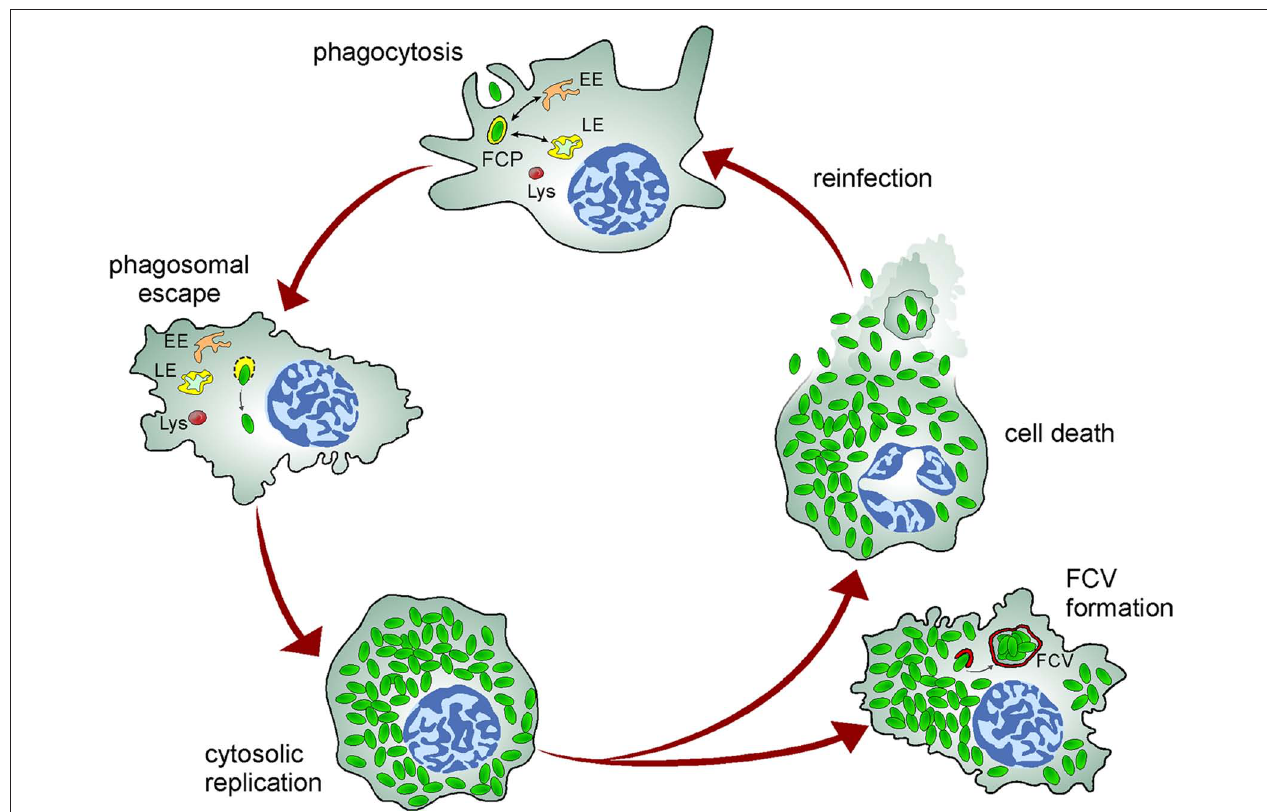
Figure 2 | Model of the Francisella intracellular cycle in macrophages. Upon phagocytosis, bacteria reside in an early phagosome (FCP) that interacts with early (EE) and late (LE) endocytic compartments but not lysosomes (Lys). Bacteria rapidly disrupt the FCP membrane and reach the cytosol where they undergo extensive replication, a process followed by cell death and bacterial release or reentry of cytosolic bacteria within Francisella -containing vacuoles (FCV) via autophagy in murine